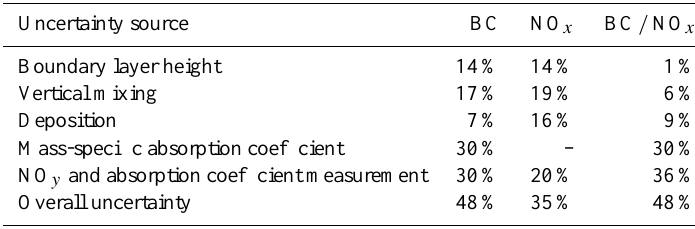
Table 3. Systematic 2 σ uncertainties on BC and NO x error factors and BC / NO x error factor ratio from various sources, and associated confidence intervals on average emission error biases for the three inventories.